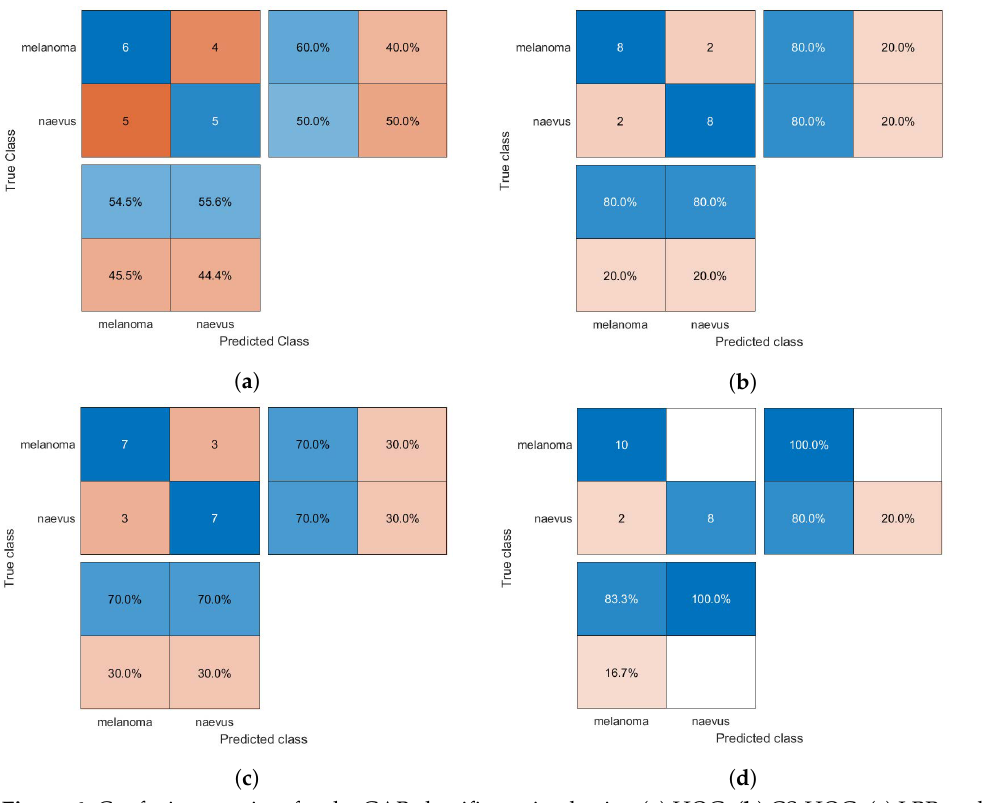
Figure 6. Confusion matrices for the GAB classifier trained using ( a ) HOG, ( b ) CS-HOG, ( c ) LBP, and ( d ) N-LBP